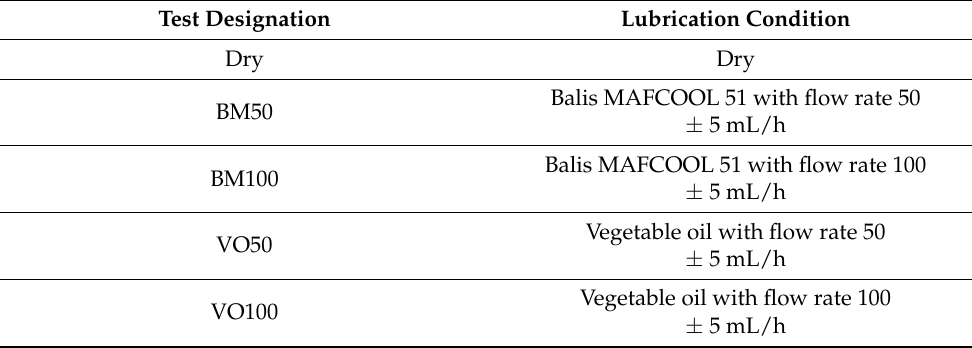
Table 1. Machining tests groups.